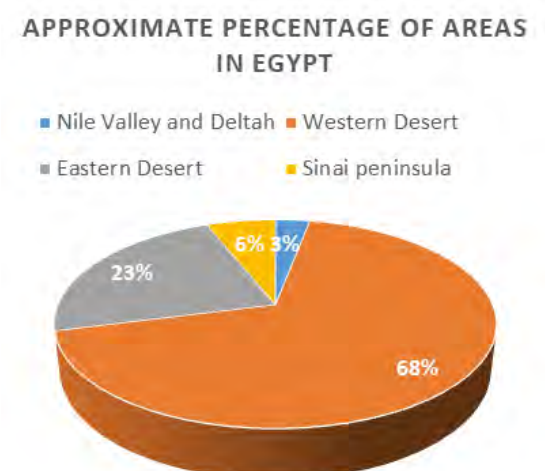
Figure 4. A graph showing the proportions of flats in Egypt – developed by the researchers. Source: Central Agency for public Mobilization andstatistics in Egypt - www.capmas.gov.eg Statistical profile - Egypt 2016 - Central Agency forPublic Mobilization and Statistics